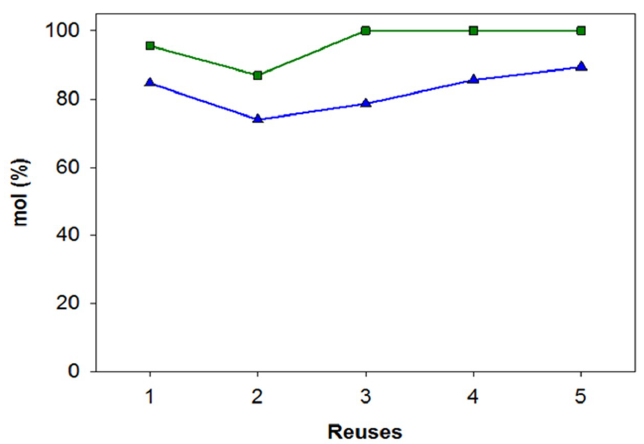
Figure 6. Catalytic performance obtained in successive reactions on FS-5 wild microbial strain extract in the sunflower oil ethanolysis reaction, under the same standard experimental conditions. Conversion (green squares) and selectivity (blue triangles).